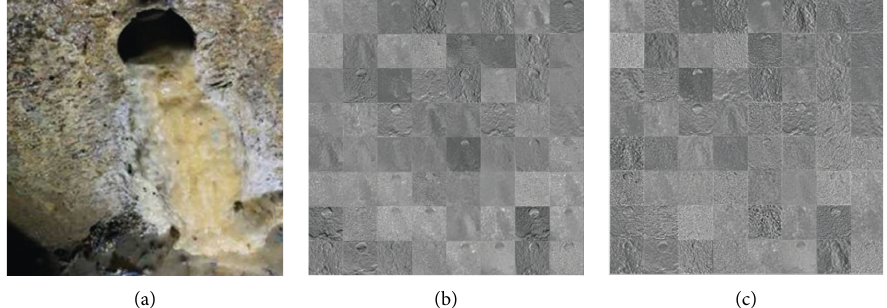
Figure 10: Feature images of res2a and res2b. (a) Raw image; (b) feature images of res2a (64 images); (c) feature images of res2b (64 images).